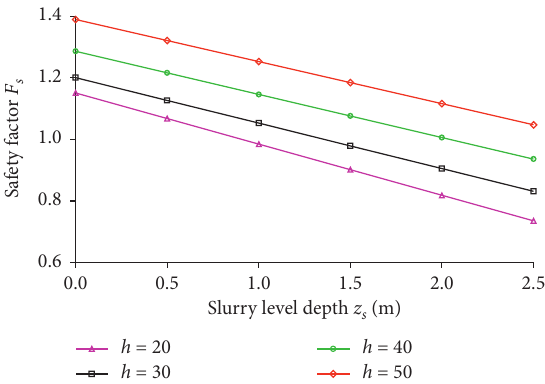
Figure 10: Relationship between safety factor and slurry level depth.